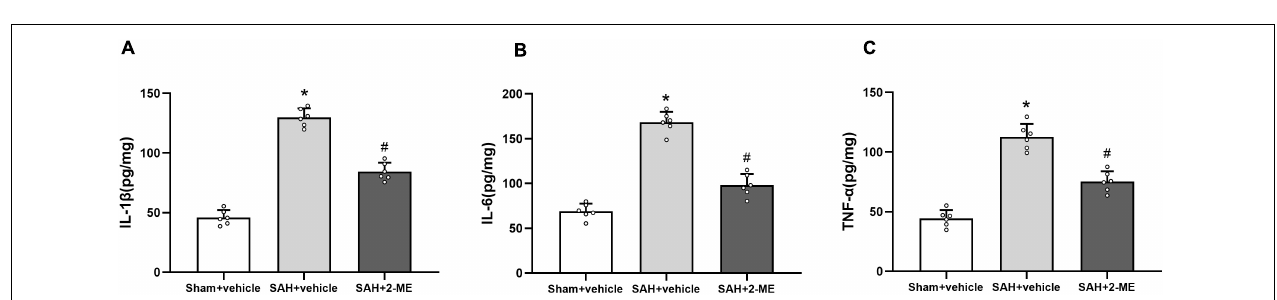
FIGURE 2 | Effect of 2-ME on cell apoptosis. (A) Representative TUNEL/DAPI staining photomicrographs of the ipsilateral basal cortex in different groups (Scale bar = 100 µ m). (B) Quantification of TUNEL-positive cells in different groups, which are expressed as the percentage of total (DAPI + ) cells. Data are shown as mean ± SD ( n = 6 per group). * P < 0.05 vs. the Sham + vehicle group; # P < 0.05 vs. the SAH + vehicle group.